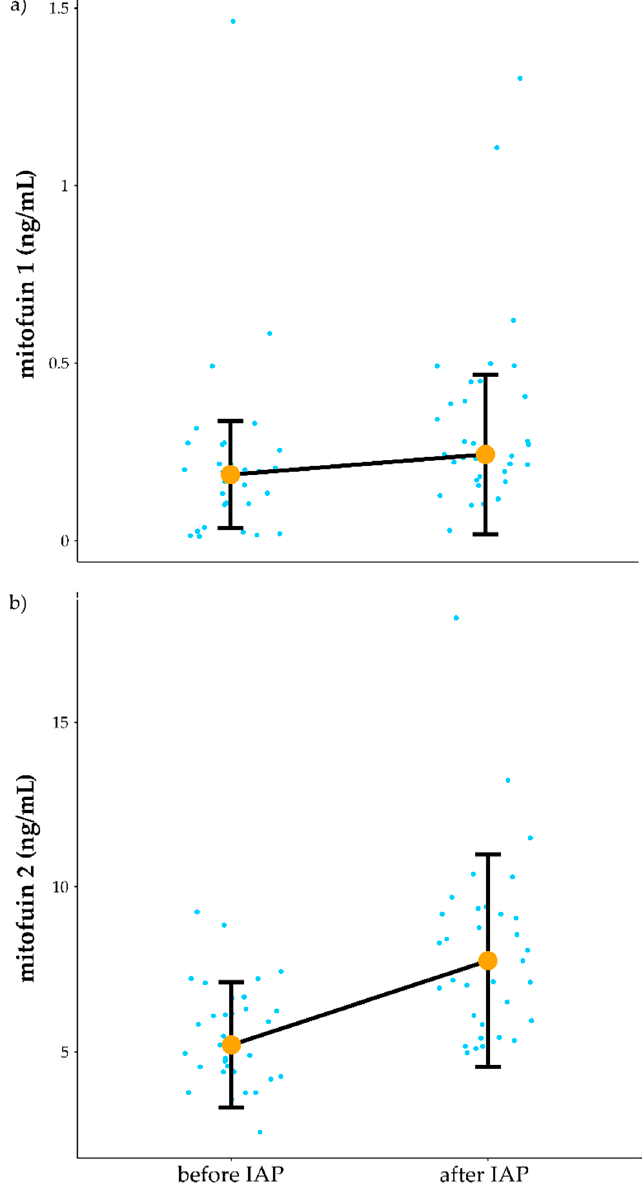
Figure 4. Influence of IAP on Mitofusins. ( a ) influence of IAP on miofusin1 level. ( b ) influence of IAP on mitofusin2 level. IAP—Individualised Activity Program, Orange dots connected by black line indicate median value, vertical black lines denote interquartile range. Blue dots before and after denote the results of individual patients.